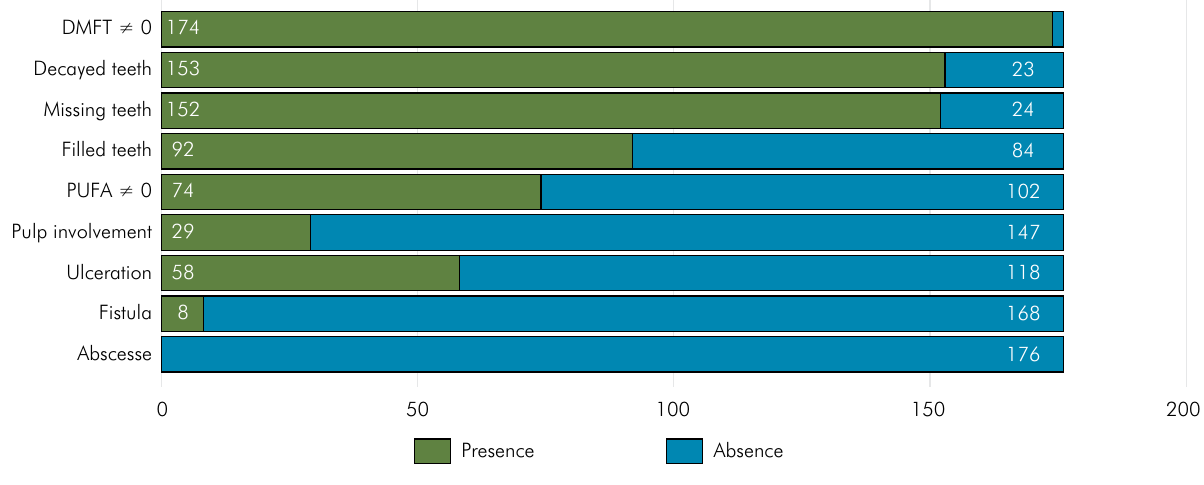
Figure 1. Oral health conditions of homeless persons, per study participants (n = 176).